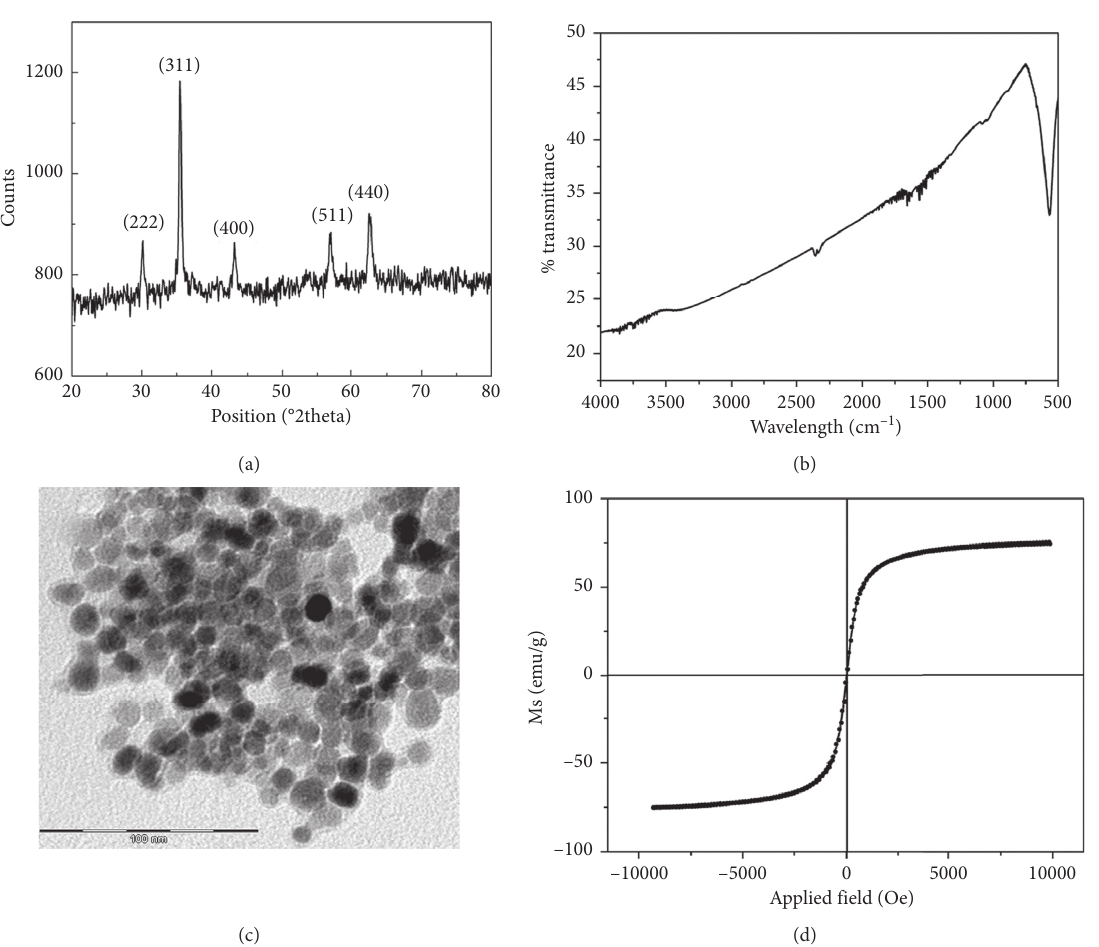
Figure 1: Characterization of the magnetic nanoparticles prepared by the coprecipitation method. (a) X-ray diffraction pattern. (b) FT-IR spectrum. (c) TEM measurement. (d) VSM